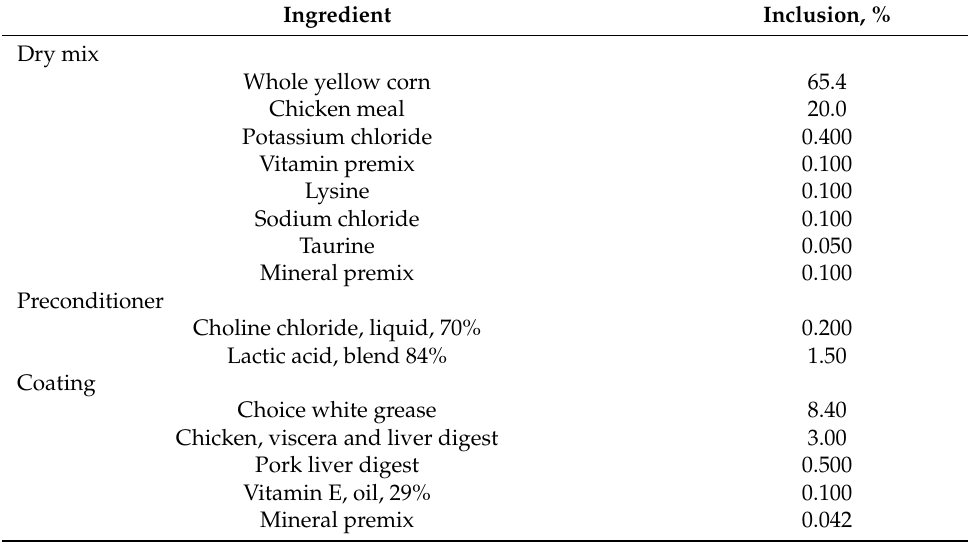
Table 1. Ingredient composition of the low, medium, and high RS experimental treatments, as-is